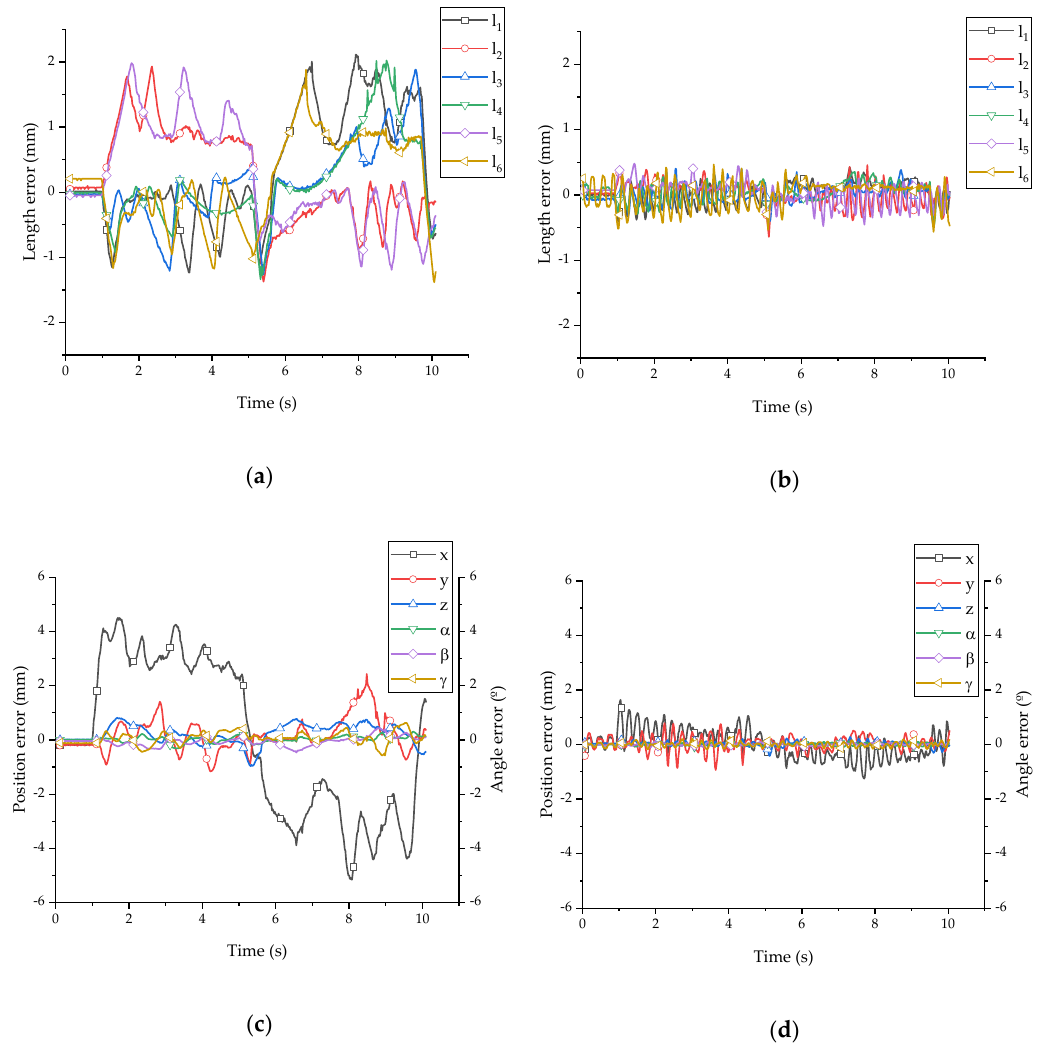
Figure 8. Positioning error graphs: ( a ) proportional integral (PI) length errors; ( b ) SMC length errors graph; ( c ) PI trajectory errors graph; ( d ) SMC trajectory errors graph.